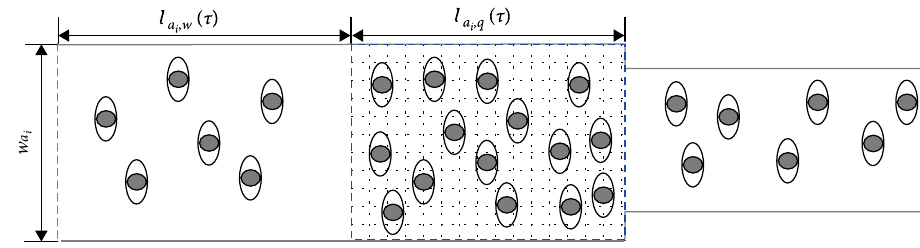
Figure 3: Disordered queuing.